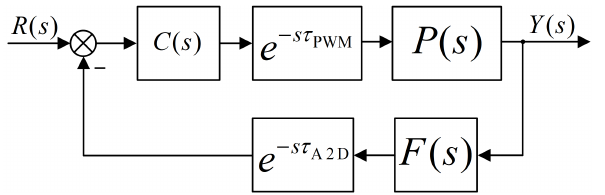
Figure 6. Block diagram of closed loop control structure with the PWM and A2D delays. The plant transfer function is represented by P ( s ) , while C ( s ) stands for controller. The PWM and A2D delays are represented by e − s τ PWM and e − s τ A2D